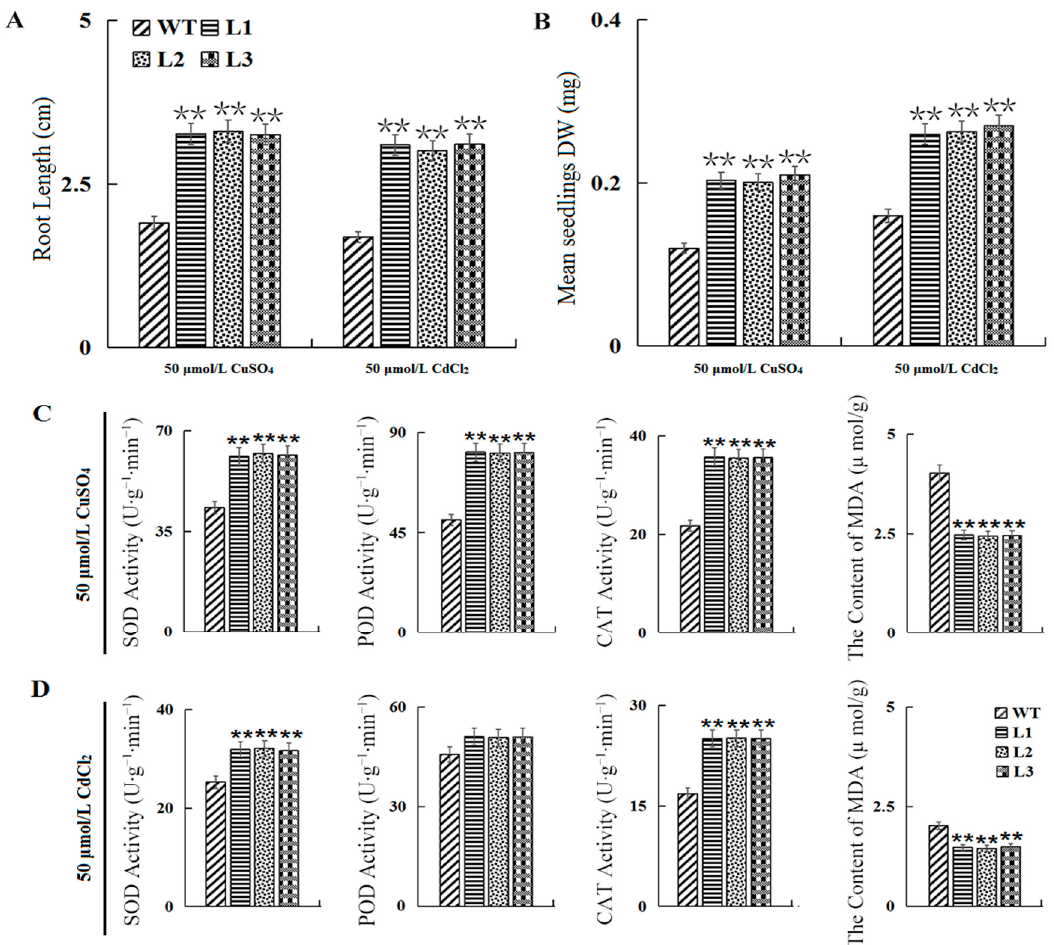
Figure 7. Effects of heavy metal stresses on antioxidase activity and seedling tolerance of WT and GmATX1 -overexpressed Arabidopsis . ( A ) Effect on the root length of the transgenic Arabidopsis seedlings after sowing on MS medium containing 50 µ mol/L CuSO 4 and 50 µ mol/L CdCl 2 , respectively, for 10 d. ( B ) Effect on DW of the transgenic Arabidopsis seedlings after sowing on MS medium containing 50 µ mol/L CuSO 4 and 50 µ mol/L CdCl 2 , respectively, for 10 d. ( C ) Activities of SOD, CAT, and POD, and contents of MDA in the leaves of seedlings of the transgenic Arabidopsis lines (L1, L2, and L3) and WT after sowing on MS medium containing 50 µ mol/L CuSO 4 for 10 d. ( D ) Activities of SOD, CAT, and POD, and contents of MDA in the leaves of the seedlings of transgenic Arabidopsis lines (L1, L2, and L3) and WT after sowing on MS medium containing 50 μ mol/L CdCl 2 for 10 d. Values shown are mean ± SD from three biological replicates. ** Indicates significant differences at p < 0.01.